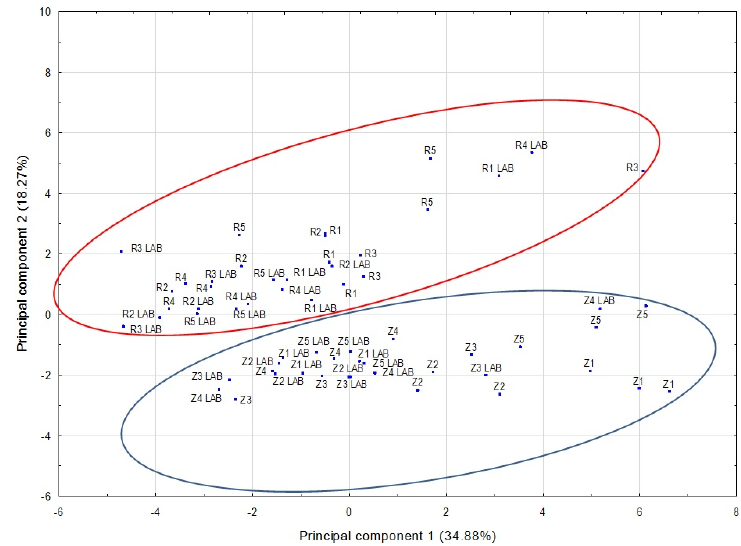
Figure 4. Score plot on the PCA plane defined by the first two principal components for alcohols found in the wine samples. Z1–Z5—Zweigelt wines in which AF was induced using various yeast strains and MLF was spontaneous. Z1 LAB–Z5 LAB—Zweigelt wines in which AF was induced using various yeast strains (the same strains as in Z1–Z5 wines) and MLF was carried out by inoculation with lactic acid bacteria. R1–R5—Rondo wines in which AF was induced using various yeast strains and MLF was spontaneous. R1 LAB–R5 LAB—Rondo wines in which AF was induced using various yeast strains (the same strains as in R1–R5 wines) and MLF was carried out by inoculation with lactic acid bacteria.